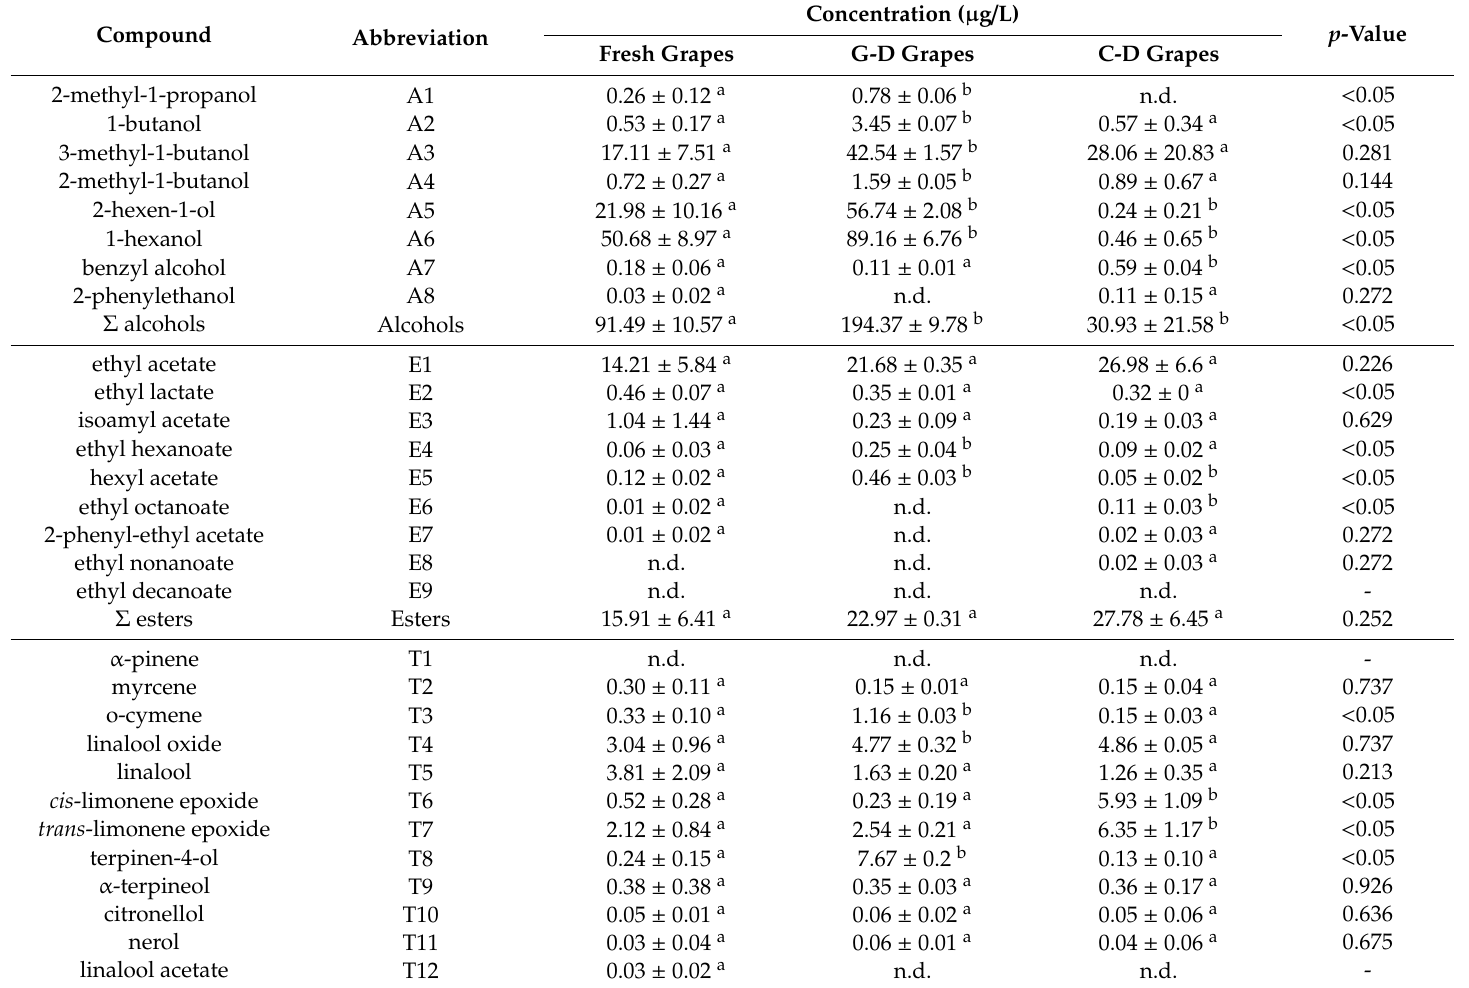
Table 2. Average values ( ± standard deviation) of free volatile compounds in fresh grapes, greenhouse-dried (G-D) grapes, and chamber-dried (C-D) grapes at 50 ◦ C. The significant di ff erences between the drying method and grapes before drying are given as p